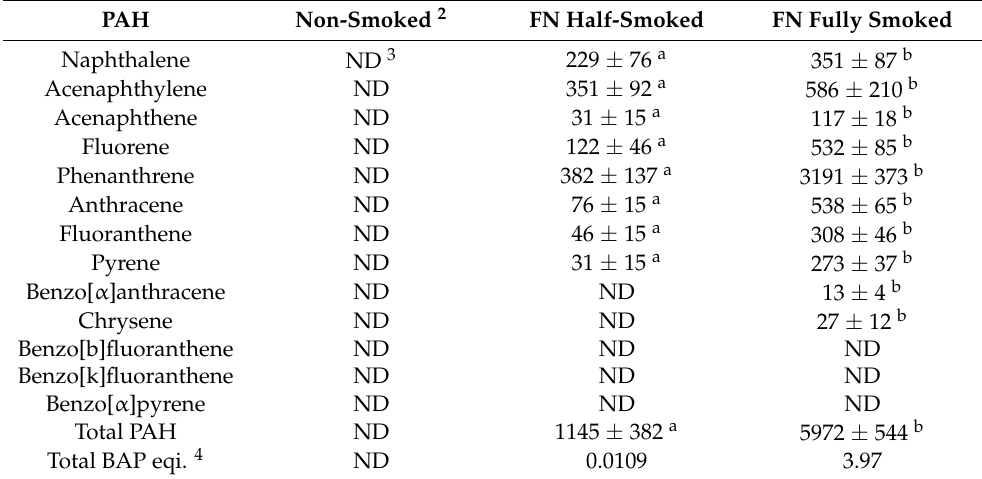
Table 1. Polycyclic aromatic hydrocarbon (PAH) content recovered from non-smoked FN and commercial salmon and half-smoked and fully smoked FN salmon 1 . PAH Non-Smoked 2 FN Half-Smoked FN Fully Smoked Naphthalene ND 3 229 ± 76 a 351 ± 87 b Acenaphthylene ND 351 ± 92 a 586 ± 210 b ND 31 ± 15 a 117 ± 18 b ND 122 ± 46